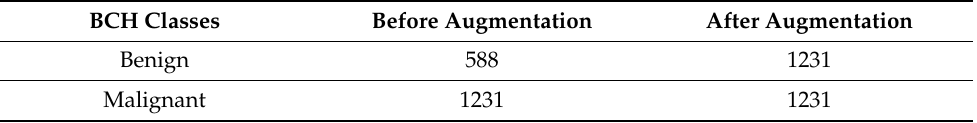
Table 5. Distribution of the images before and after image augmentation .